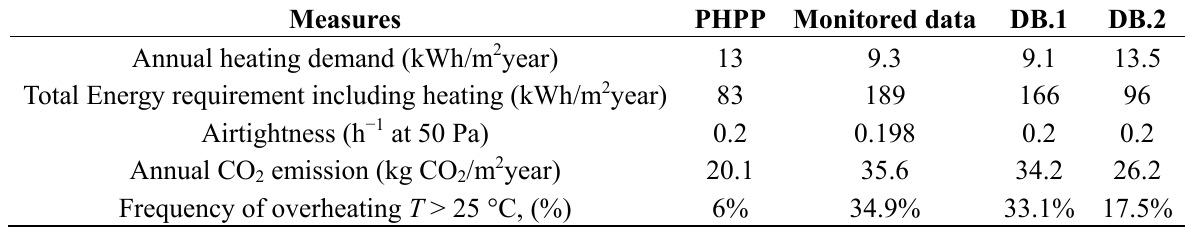
Table 1. Data comparison between PHPP, monitored data and DesignBuilder simulation results.